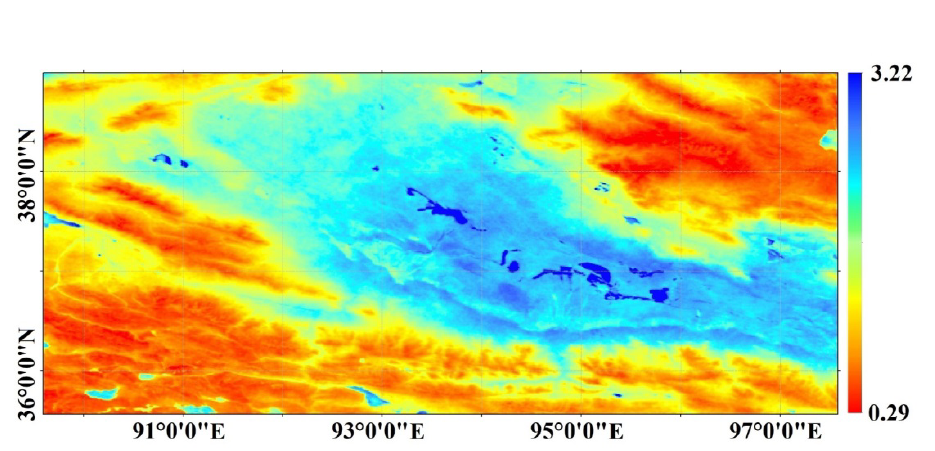
Fig. 2. 2016 (cid:794) 2019 Average PWV Content Distribution in Lenghu Region (1*1 km 2 ).